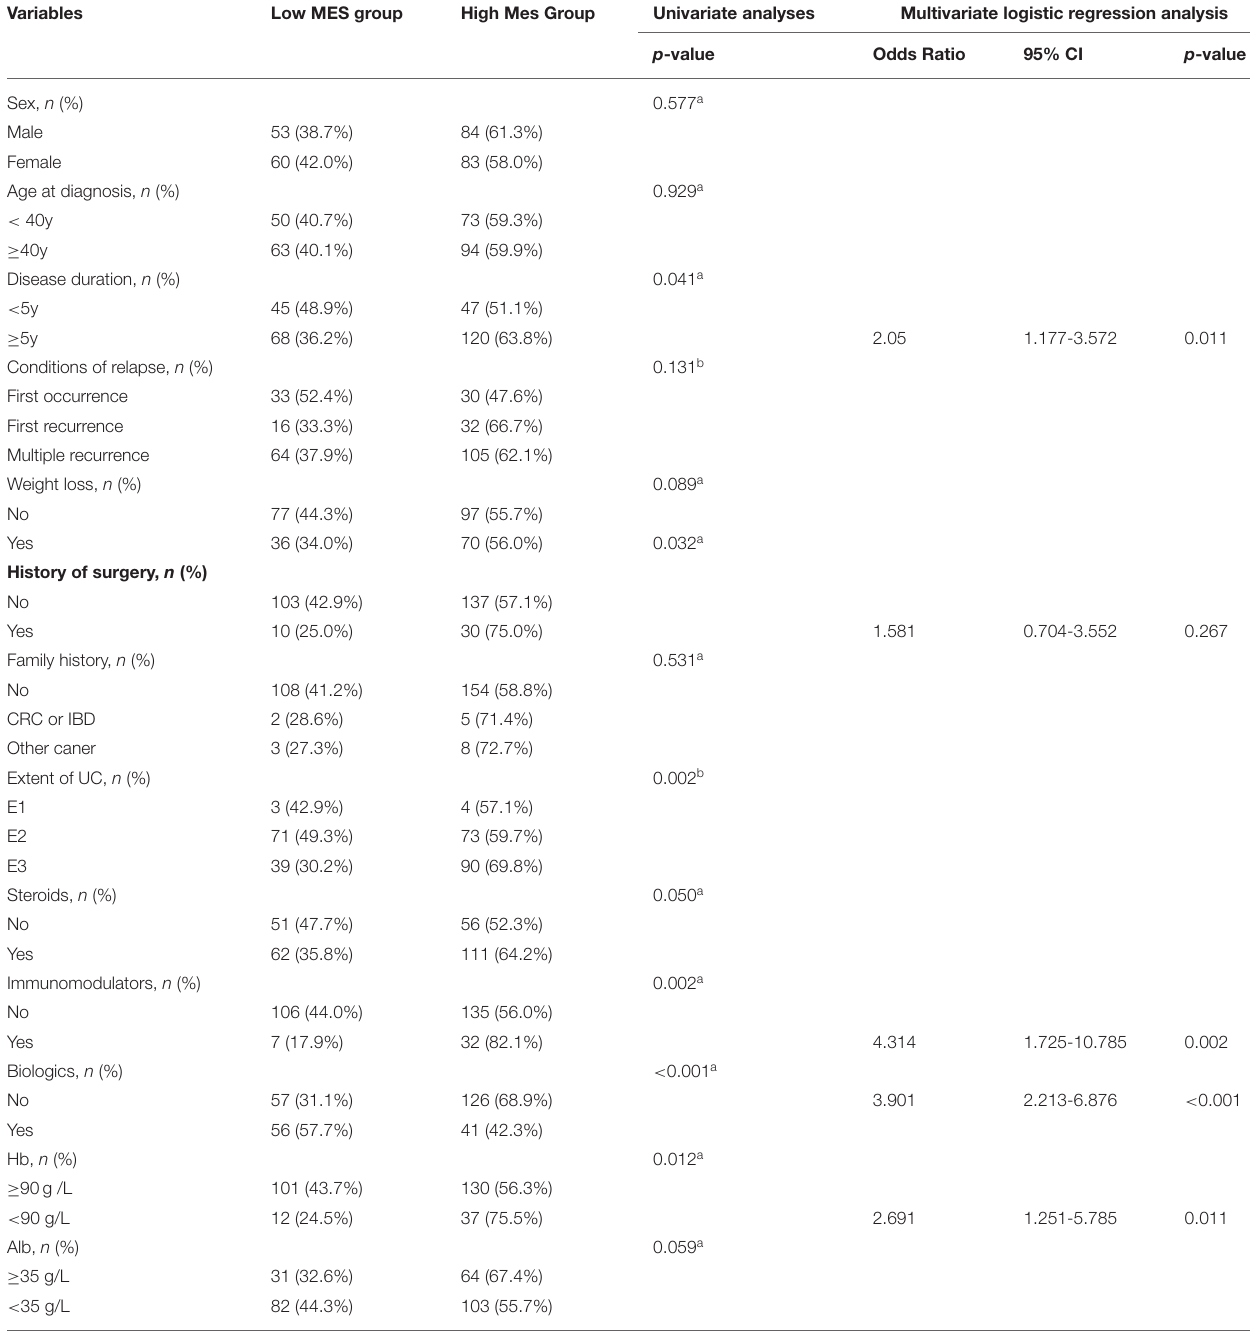
TABLE 4 | Univariable analysis and multivariate logistic regression analysis of risk factors for high MES in UC. Variables Low MES group High Mes Group Univariate analyses Multivariate logistic regression analysis p -value Odds Ratio 95%